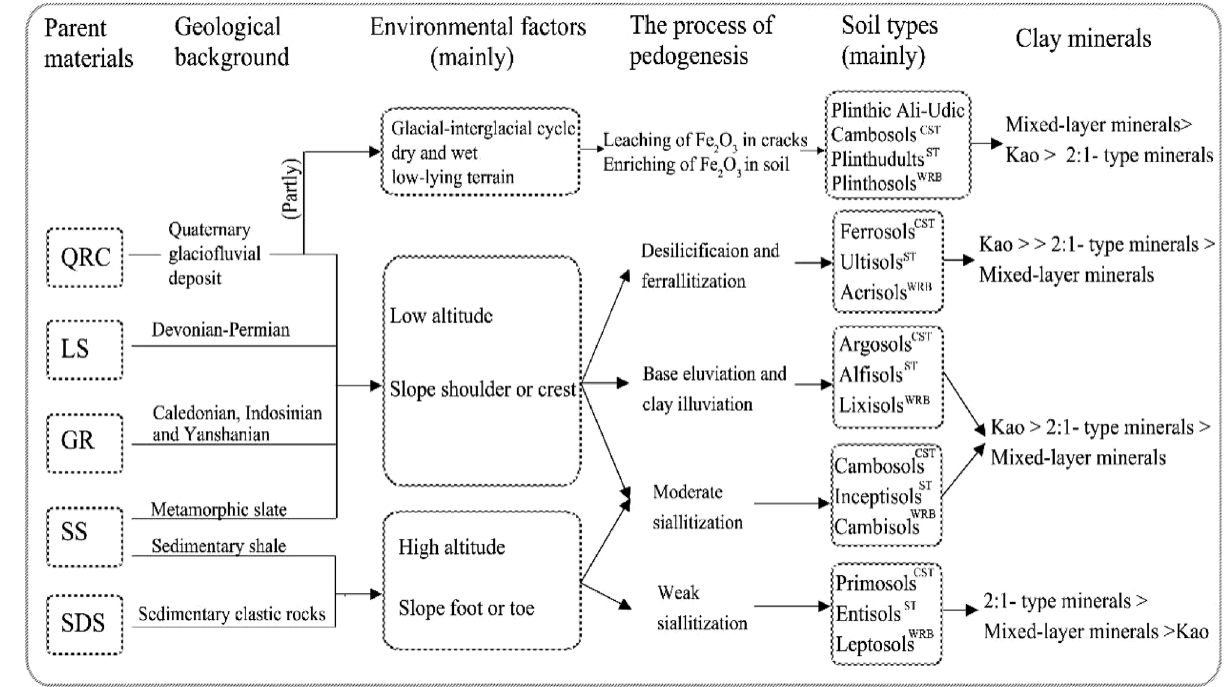
Figure 9. Schematic representation of the conditions leading to evolution of the clay mineral composition in studied upland soils in Hunan, China (GR: granite; LS: limestone; QRC: Quaternary red clay; SS: slate